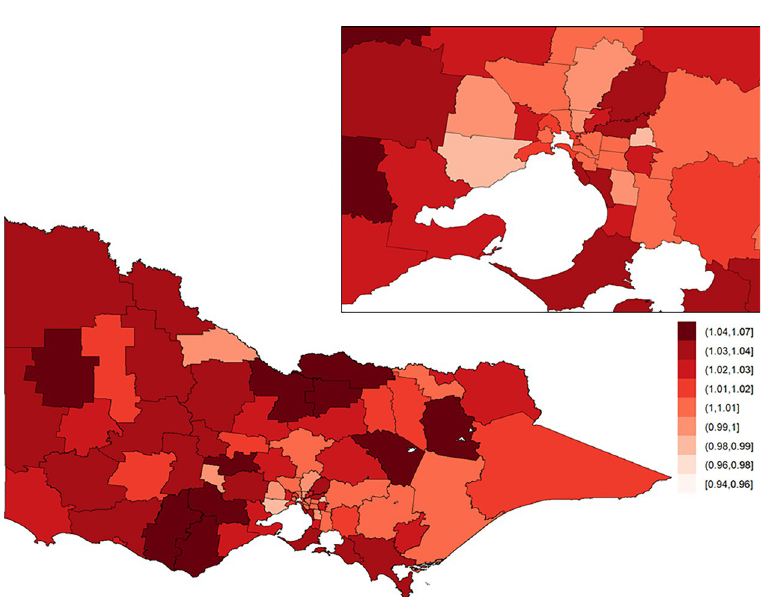
Fig 8. Area-specific yearly multiplicative change in risk of injury by motor vehicle collision in Victoria. Here, a value of one indicates that the area-specific risk is stable over time; a value greater than one indicates that the area- specific risk is increasing over time; and a value less than one indicates that the area-specific risk is declining over time. The inset on the top-right shows Greater Melbourne.